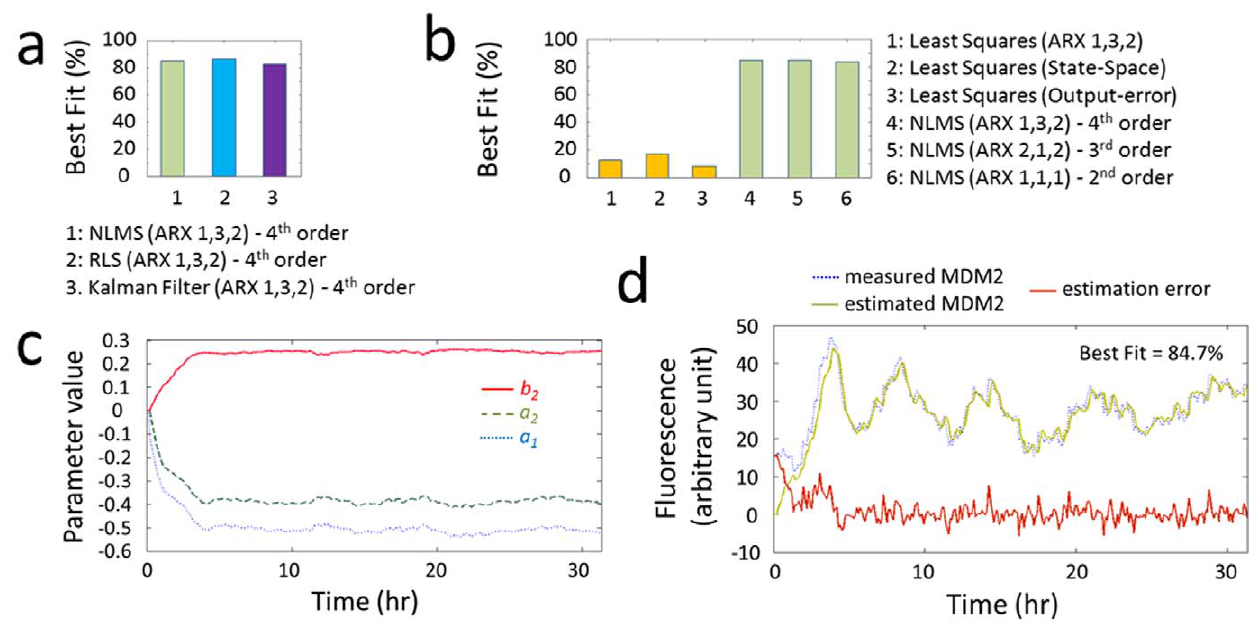
Figure 2. A time-variant model using adaptive filtering. ( a ) The three types of adaptive filter implementations (NLMS, RLS, and Kalman filter) achieve similar Best Fit scores (near 80%) with the 4 th order ARX model ( n a =1, n b =3, n k =2). ( b ) Adaptive filtering-based time-variant models (4, 5, and 6) outperform time-invariant models (1, 2, and 3). The performance of the adaptive filter is insensitive to the order of the model in these simulations; with NLMS, a 3 rd order grey-box ARX model ( n a =2, n b =1, n k =2) and a 2 nd order ARX model ( n a =1, n b =1, n k =1) performing as well as the 4 th order ARX model ( n a =1, n b =3, n k =2). The ARX n a , n b , and n k values are enclosed by parentheses in the figure. ( c ) Parameter tracking by the NLMS filter for the 3 rd order ARX model ( n a =2, n b =1, n k =2). Each color line represents the changing values of a single parameter. ( d ) The NLMS algorithm enables the model to closely match measurements, increasing the Best Fit score to 84.7%. The estimation errors are reduced after an initial brief ‘‘learning’’ period for the adaptive